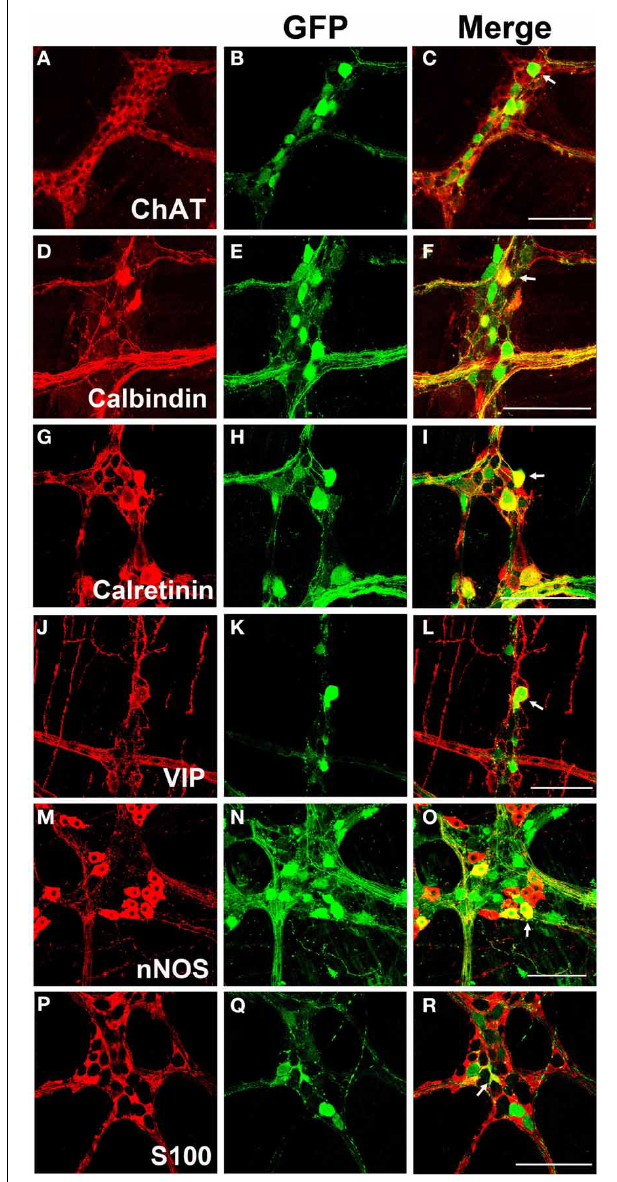
FIGURE 6 | Chemical coding of transduced myenteric cells in the colon after systemic scAAV8 injection. Similarly to scAAV9, systemic injection of scAAV8-CB-GFP produced GFP expression (B,E,H,K,N,Q) was detected in ChAT (A–C) , calbindin (D–F) , and calretinin (G–I) positive excitatory neurons, interneurons and intraganglionic fibers. Additionally, GFP expression was also detected in VIP (J–L) and nNOS (M–O) positive inhibitory neurons, interneurons, and intraganglionic fibers. GFP expression was occasionally detected in S100 positive enteric glia (P–R) . White arrows in merged images indicate transduced cells. Scale bars are 100 μ